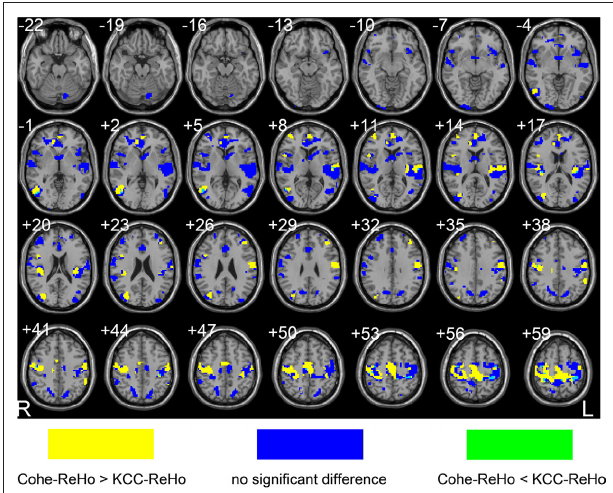
FIguRe 5 | Cohe-ReHo and KCC-ReHo have different sensitivity to the difference of local synchronization between eO and eC resting states. Yellow color means Cohe-ReHo is more sensitive than KCC-ReHo. The green color means the opposite. The blue color means that the two measurements have no significant differences in their sensitivity in detecting differences between EC and EO. The left side of the image corresponds to the right side of brain.